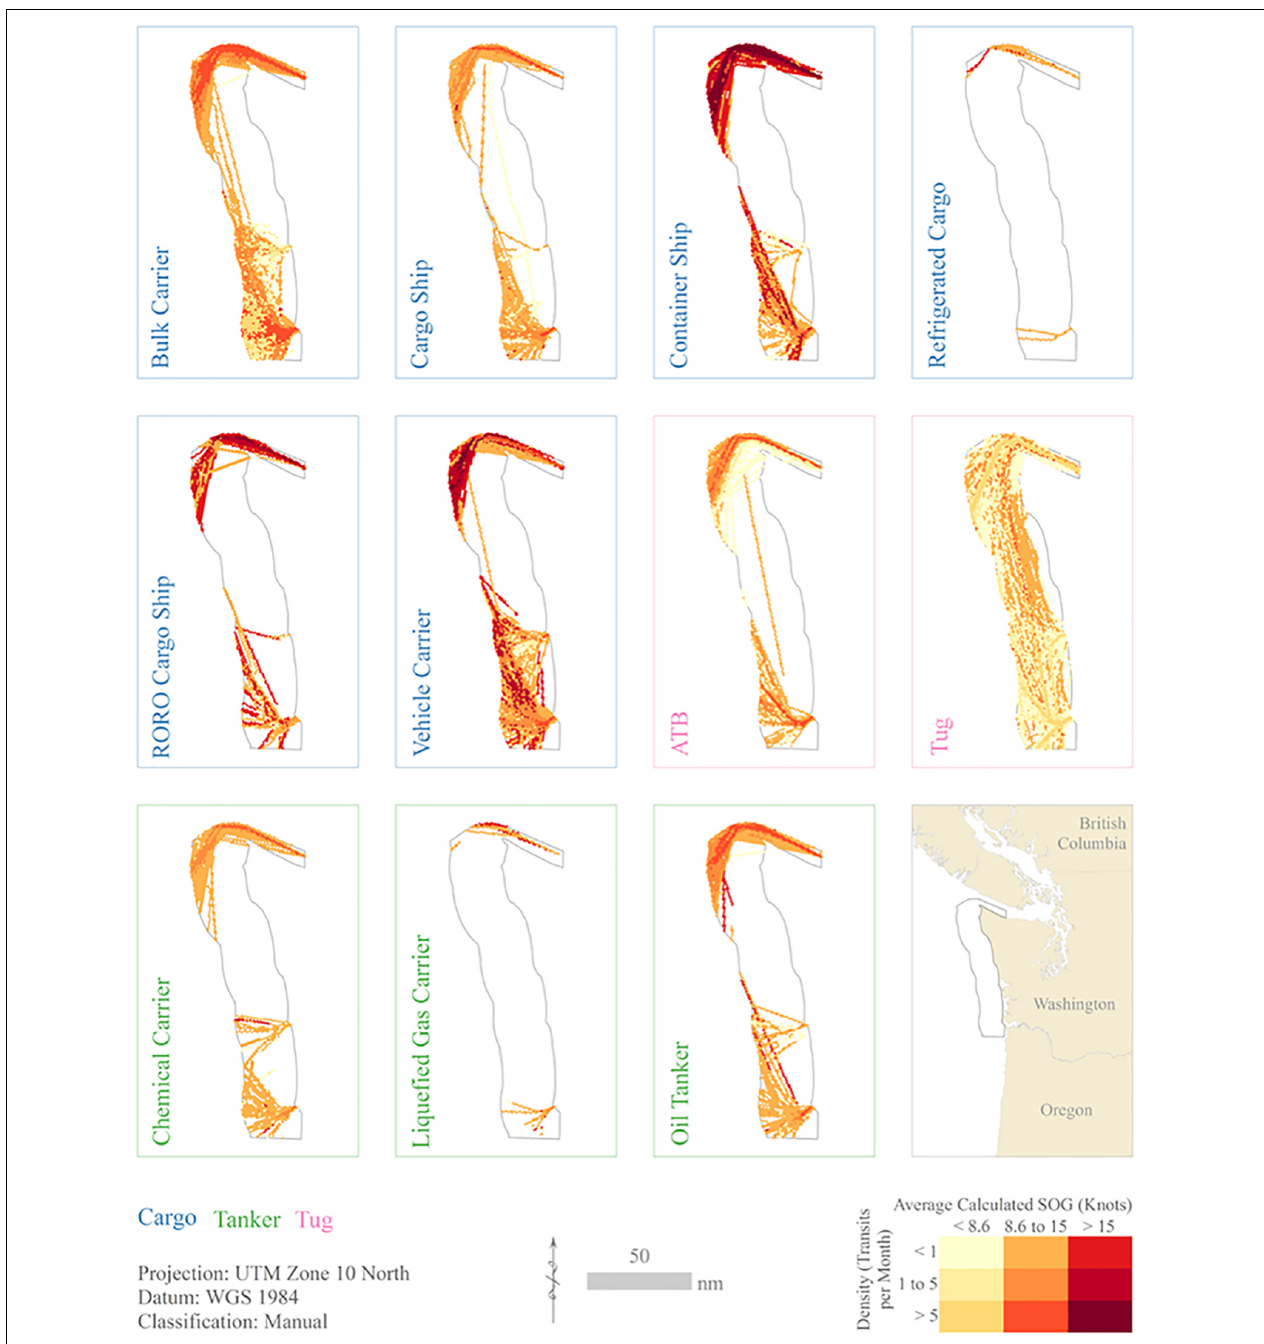
FIGURE 4 | Average calculated speed over ground (SOG) and vessel transits per month in the gray whale potential presence Biologically Important Area (BIA) for 2013 and 2014. Darker colors represent faster average speeds and more transits per month for each vessel type. The unit of observation is the square statute mile